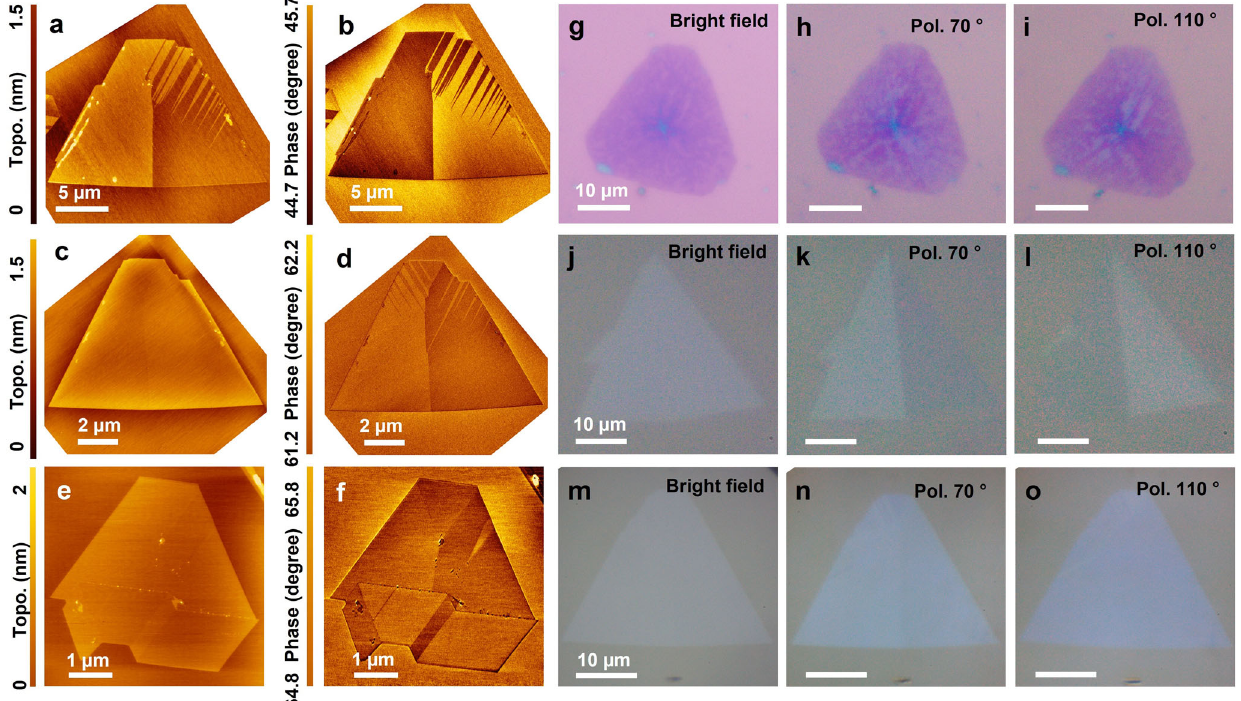
Fig. 4 Size dependence and substrate effects. a , b The DFM topography image and phase image of 20 µ m 1L-ReS 2 grown on fl uorophlogopite mica. c , d The DFM topography image and phase image of 10 µ m 1L-ReS 2 grown on fl uorophlogopite mica. e , f The DFM topography image and phase image of 5 µ m 1L-ReS 2 grown on fl uorophlogopite mica. g – i , j – l , m – o The optical micrographs of CVD-grown ReS 2 on 300 nm SiO 2 /Si, c-face sapphire, and fl uorophlogopite mica substrates,